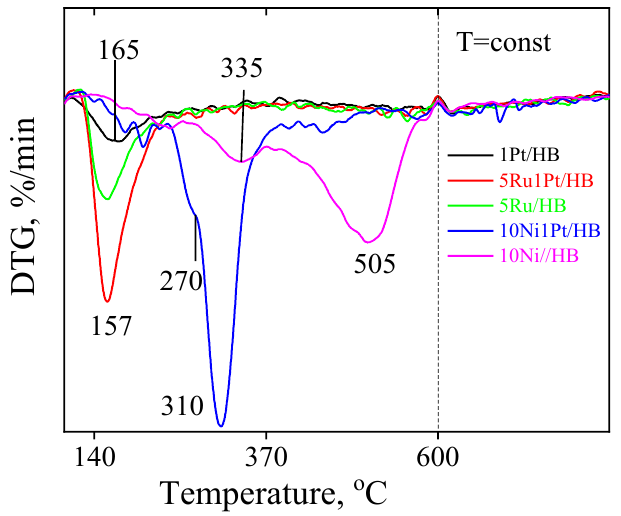
Figure 3. TPR profiles of the Ni-, Ru-, and Pt-modified nanosized Beta zeolites. The band at 3735 cm − 1 in the ATR FTIR spectrum [21] of the parent Beta zeolite is ascribed to the presence of internal SiOH groups (Figure S1). The shift of this band is registered for the modified zeolites and it is due to the strong interaction of the applied metals with the silanol groups of the